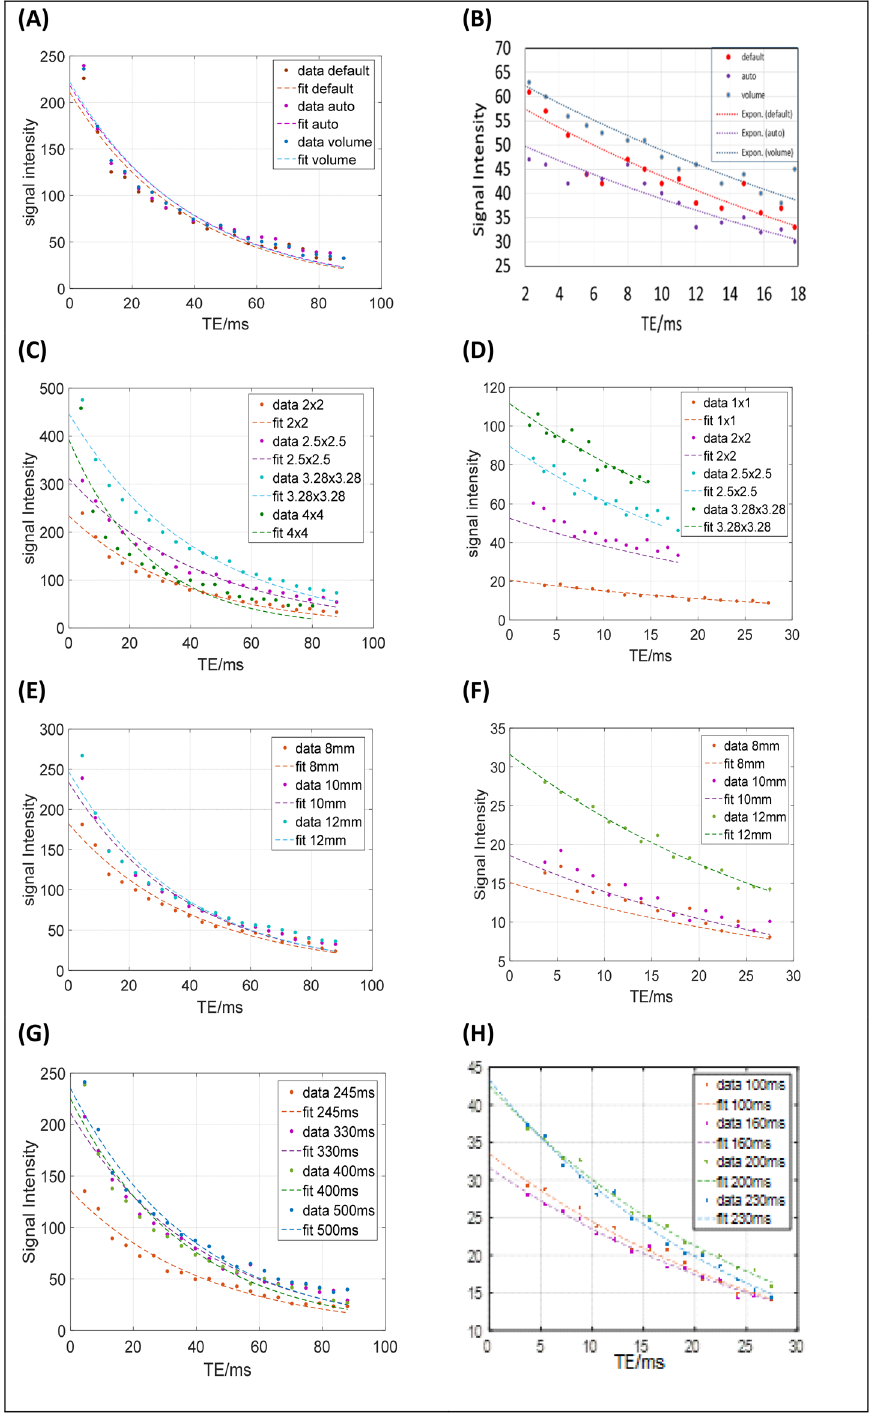
Figure 2. Decay curves of T2 and T2* for a healthy volunteer using: the three shim techniques ( A , B ), pixel sizes of 2 × 2 to 4 × 4 mm for T2 ( C ), pixel sizes of 1 × 1 to 3.28 × 3.28 mm for T2* ( D ), slice thicknesses of 8, 10, 12 mm ( E , F ), TR values 245–500 ms for T2 ( G ) and TR values 100–230 ms for T2* ( H